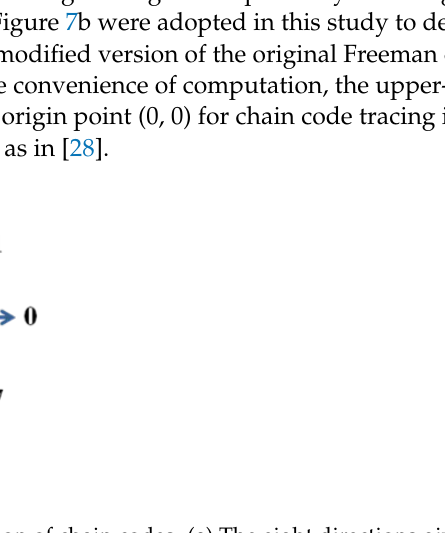
Figure 7. An illustration of chain codes. ( a ) The eight directions given by Freeman chain codes [28]. ( b ) The new eight directions used in this study.